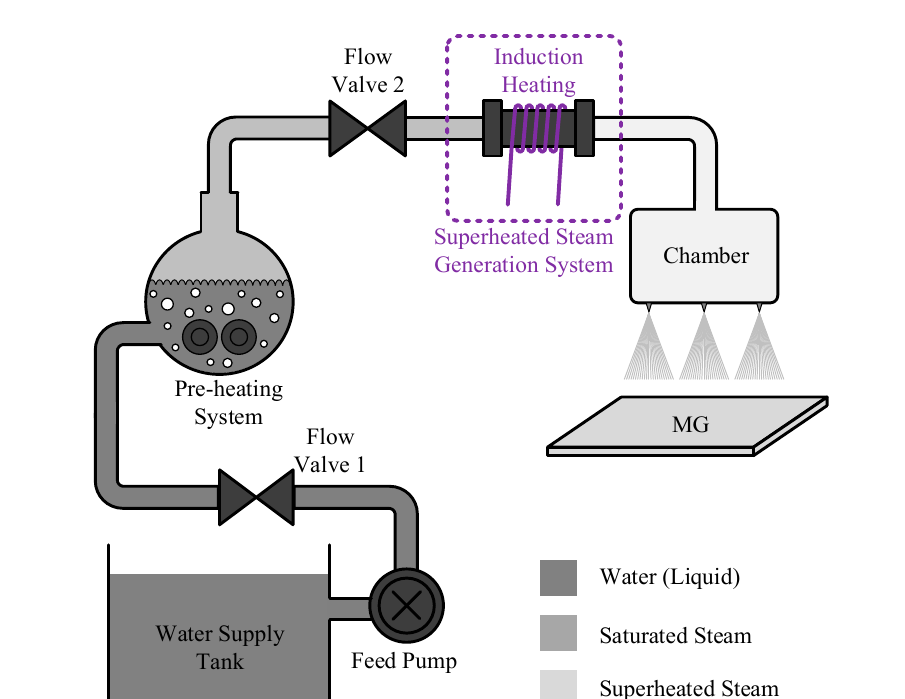
Figure 3. Steam heating structure of the cleaning equipment. MG, mother glass.